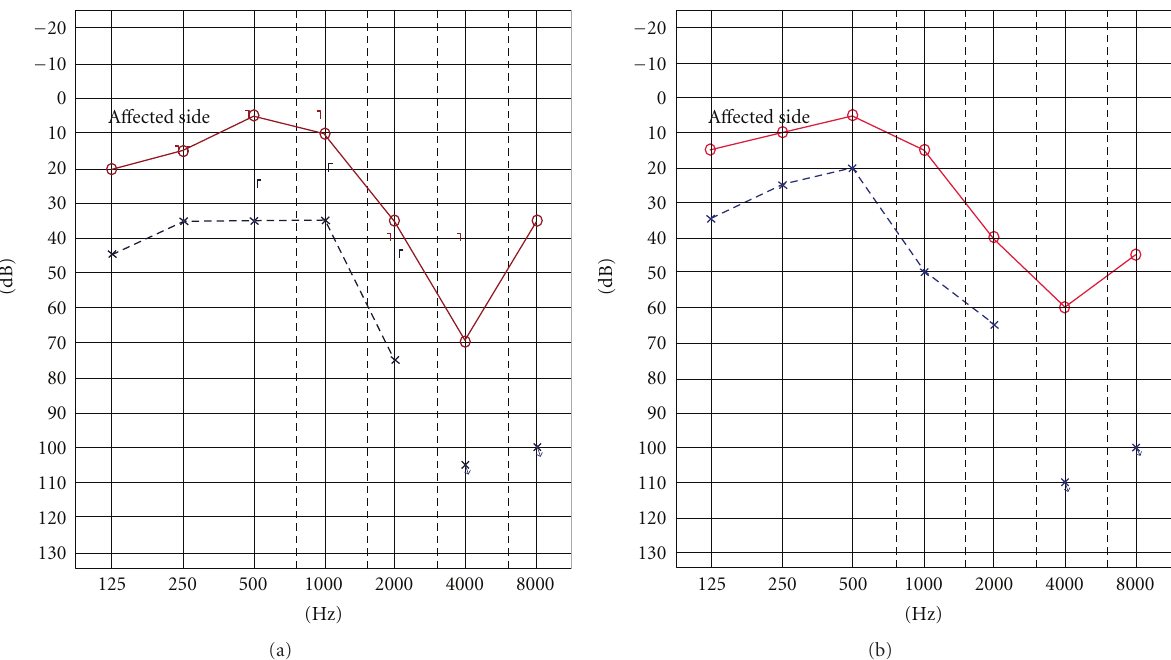
Figure 5: (a) Preoperative and (b) postoperative pure-tone audiogram. No hearing disturbance was observed after the surgery.